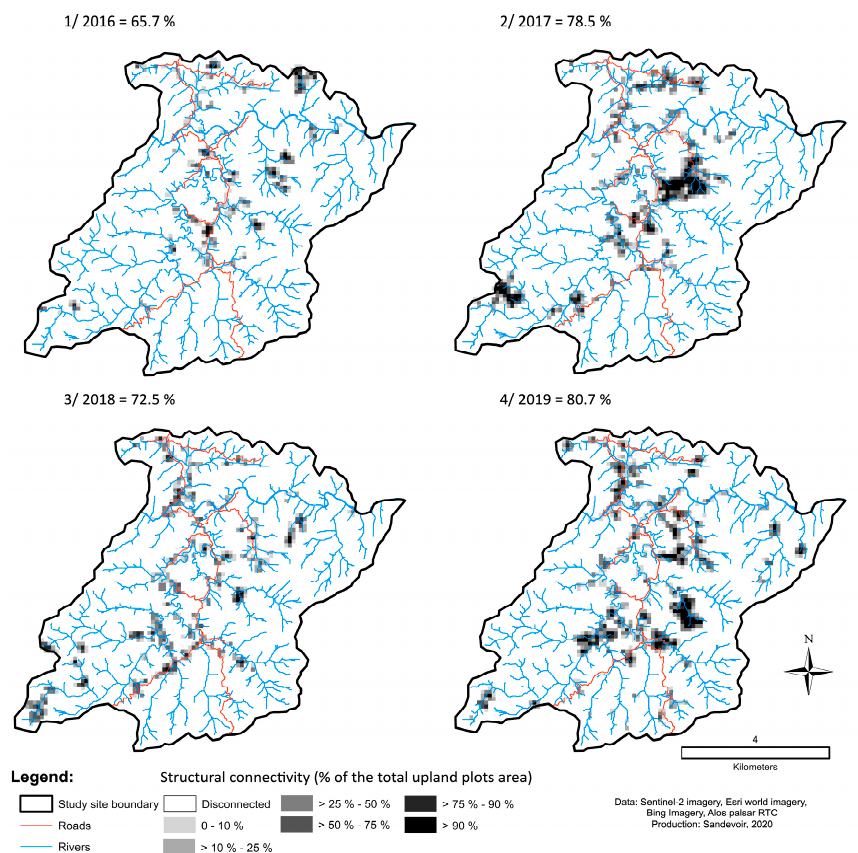
Table 6. Area by structural connectivity growth type since 2016.